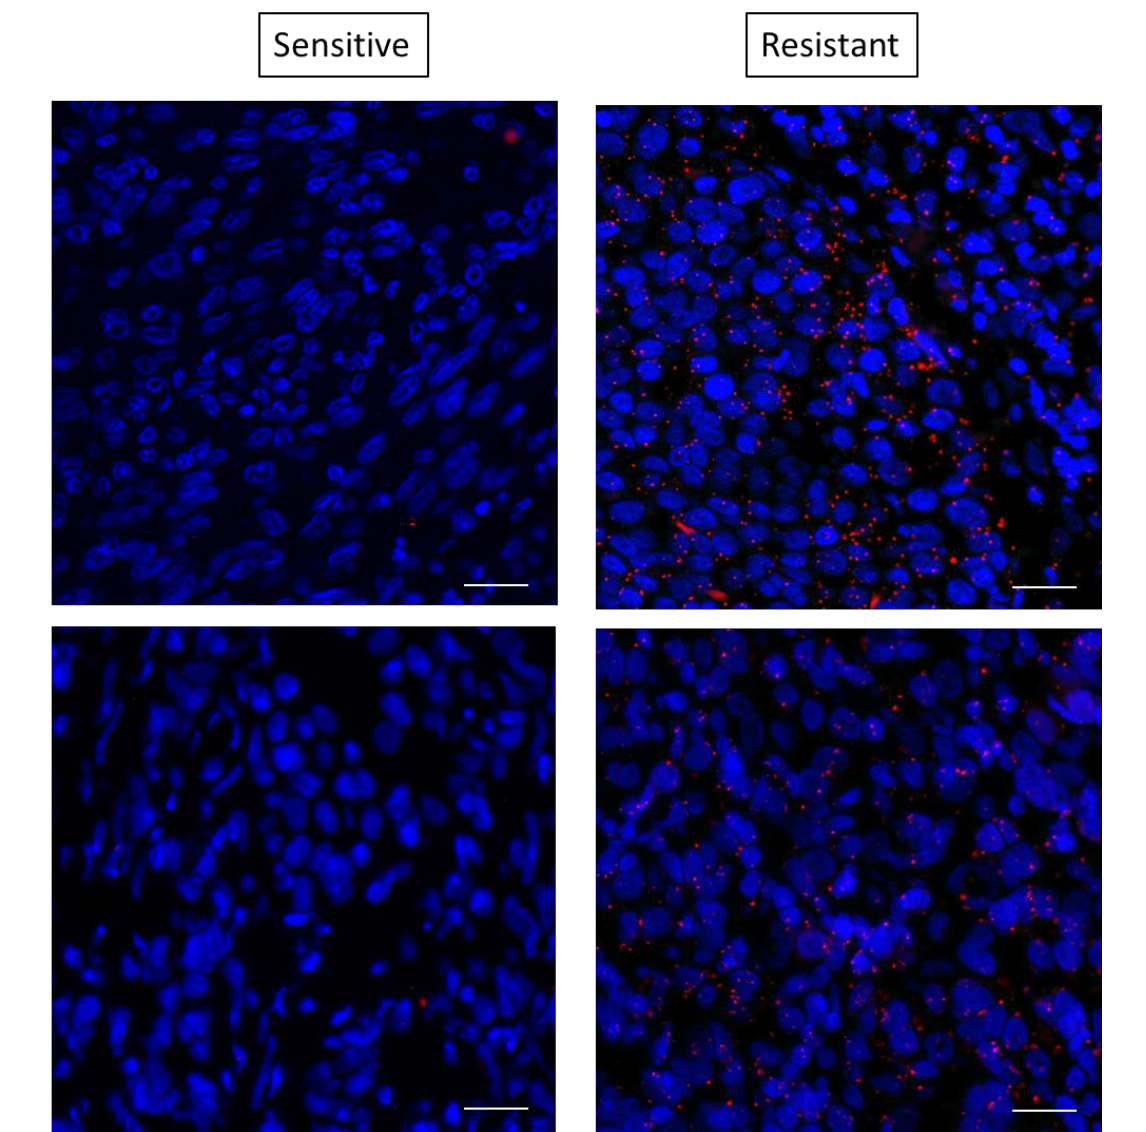
Figure 7. RAS interacts with RICTOR in resistant melanoma. Representative pictures of RAS–RICTOR interactions assessed by in situ PLA (red dots) in paraffin sections of 2 metastatic human melanoma samples before treatment and after resistance occurred. DAPI-stained cell nuclei (blue). Scale bar, 50 μm.